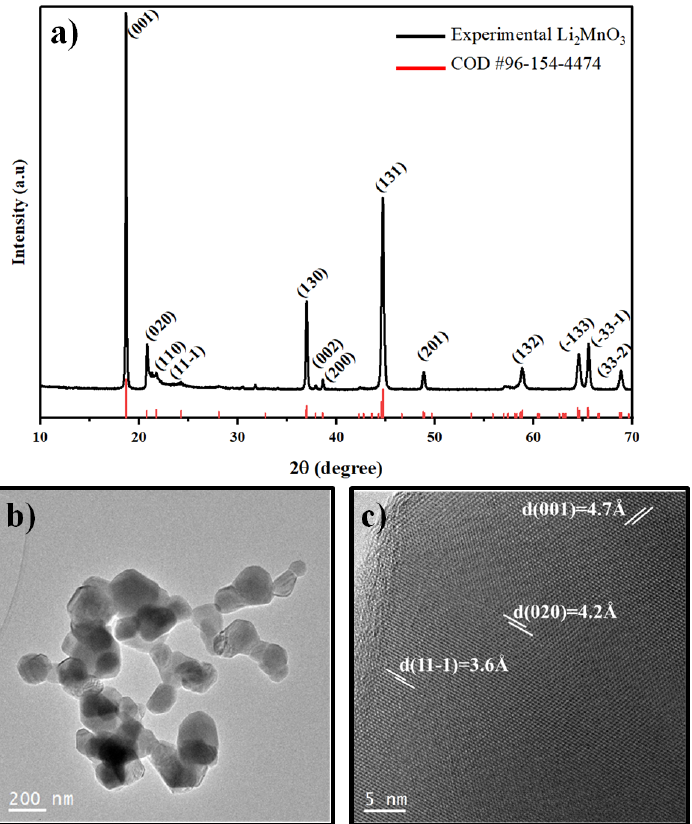
Figure 2. ( a ) X-ray diffraction pattern and ( b , c ) Transmission Electron Microscopy images of the Li 2 MnO 3 powder material used in this